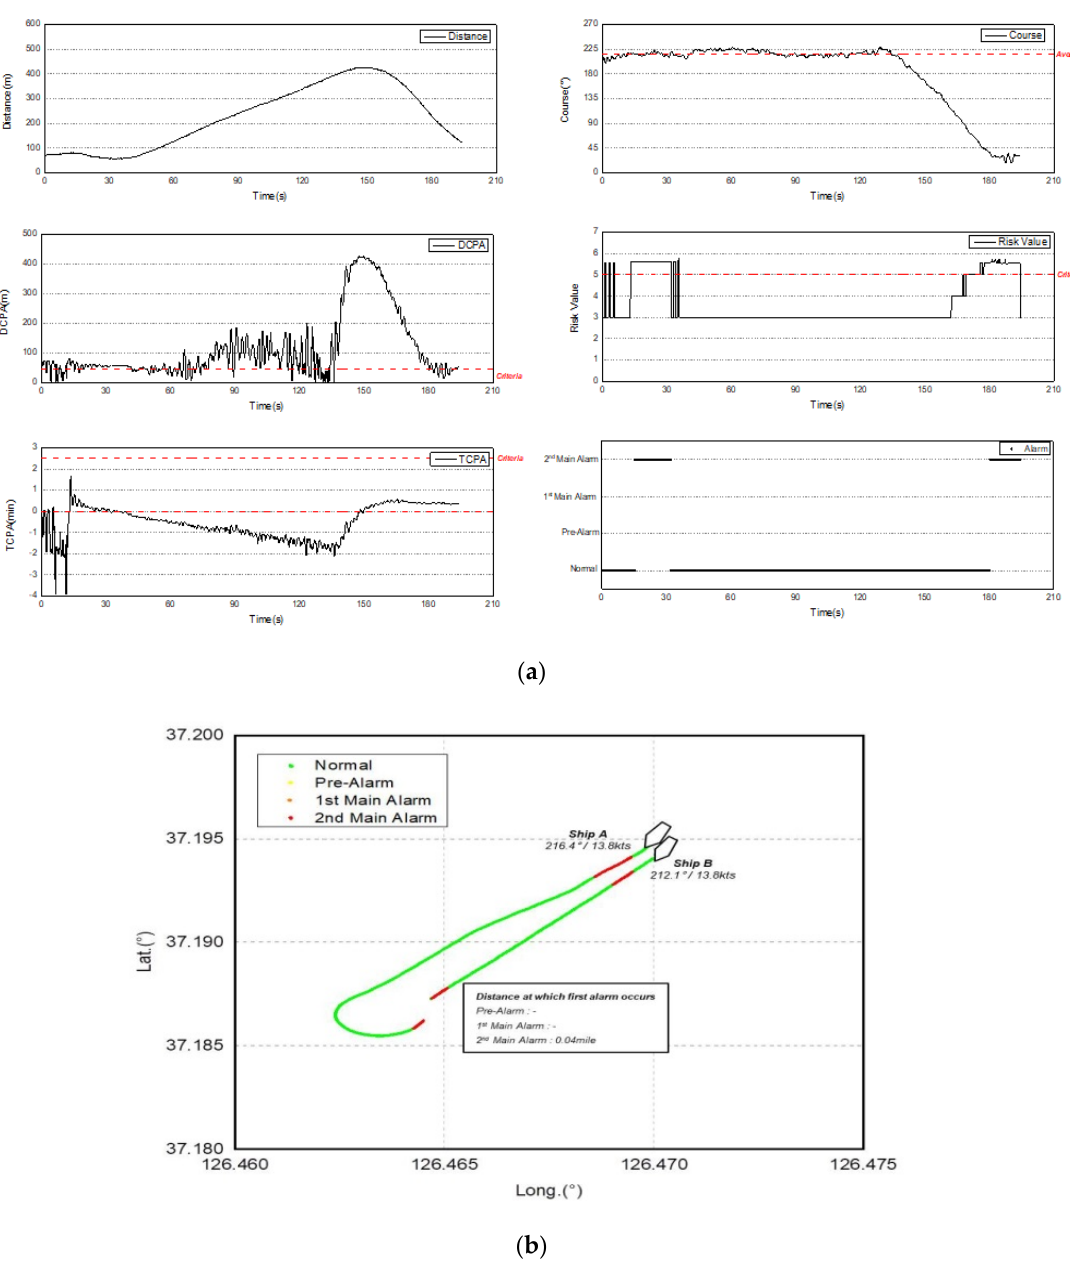
Figure 15. ( a ) Experimental results; ( b ) track and alarm analysis for.